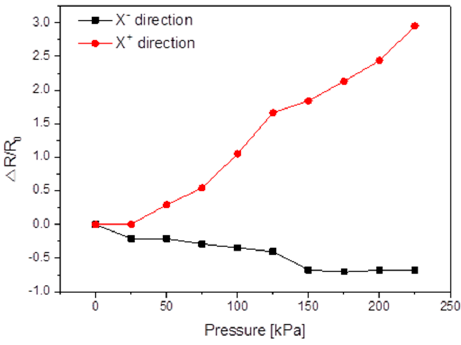
Figure 7. Shear pressure response of the MWCNT/PDMS tactile sensor having interlocking curved micropillars after Ar + ion beam treatment at the incident angle of 60°. micropillars after Ar + ion beam treatment at the incident angle of 60 ˝